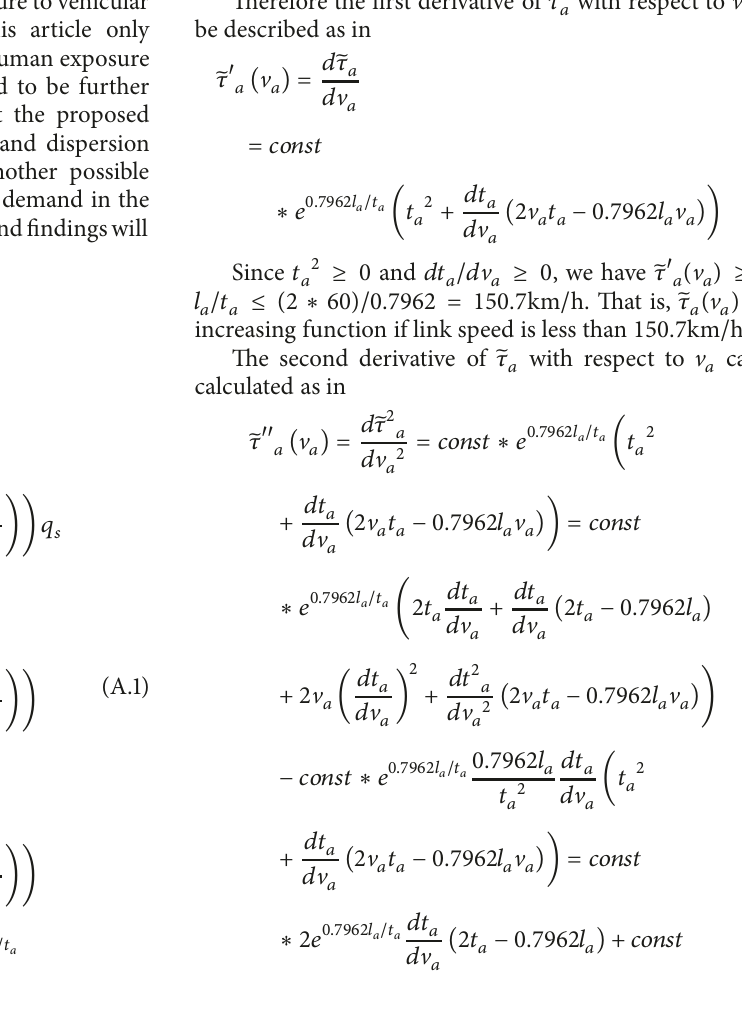
It is worthy to mention that human exposure to